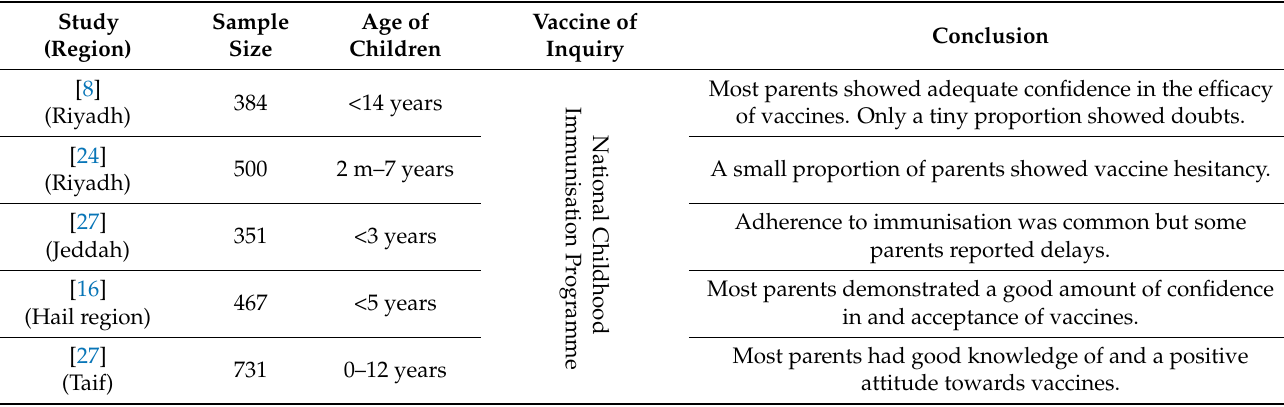
Table 1. Brief overview of the studies included for